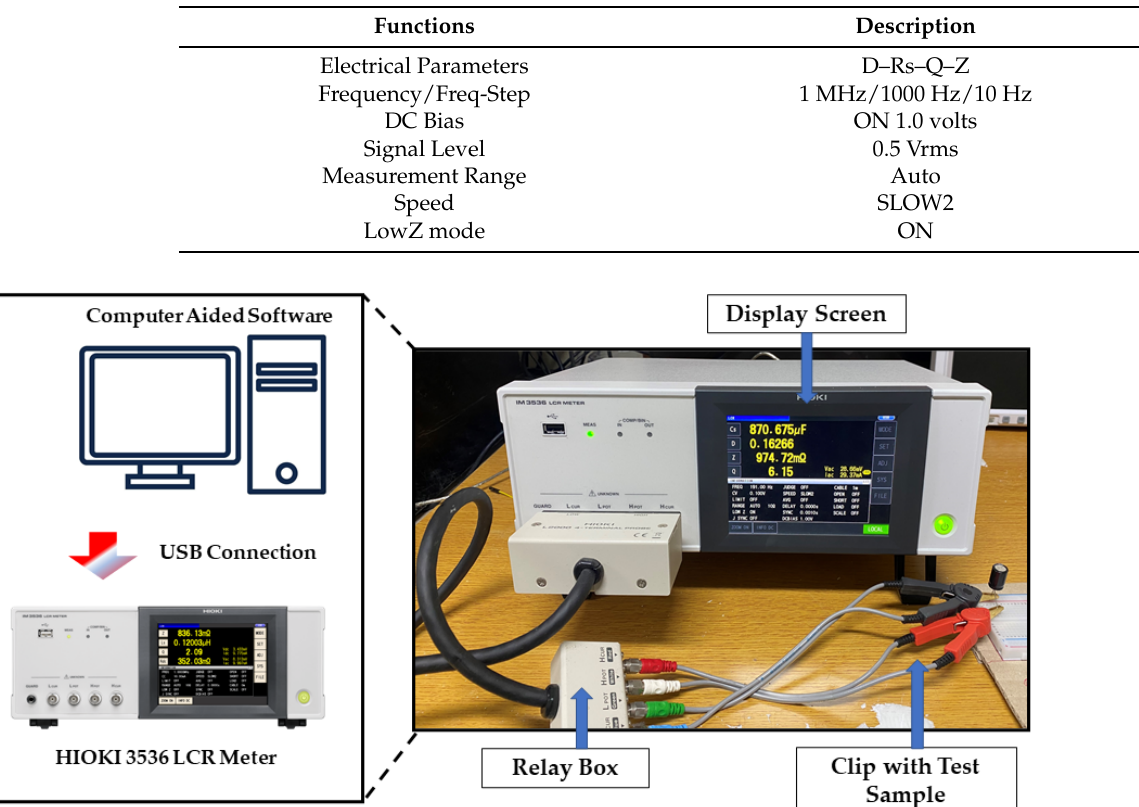
Table 3. Experimental Measurement Conditions.